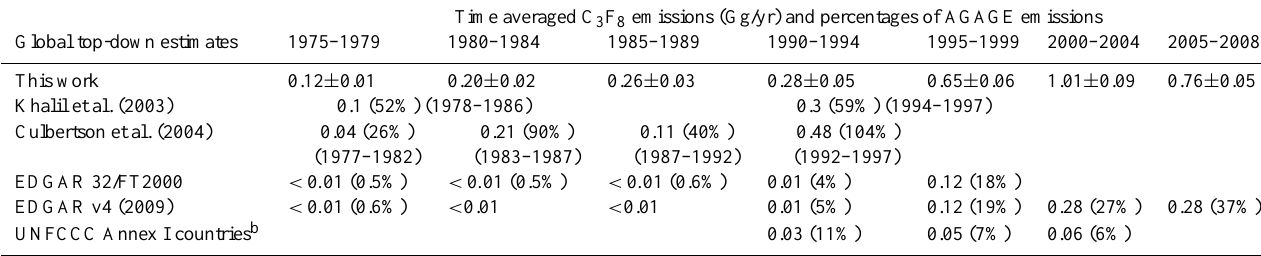
Table 8. Time averaged global C 3 F 8 emission estimates.